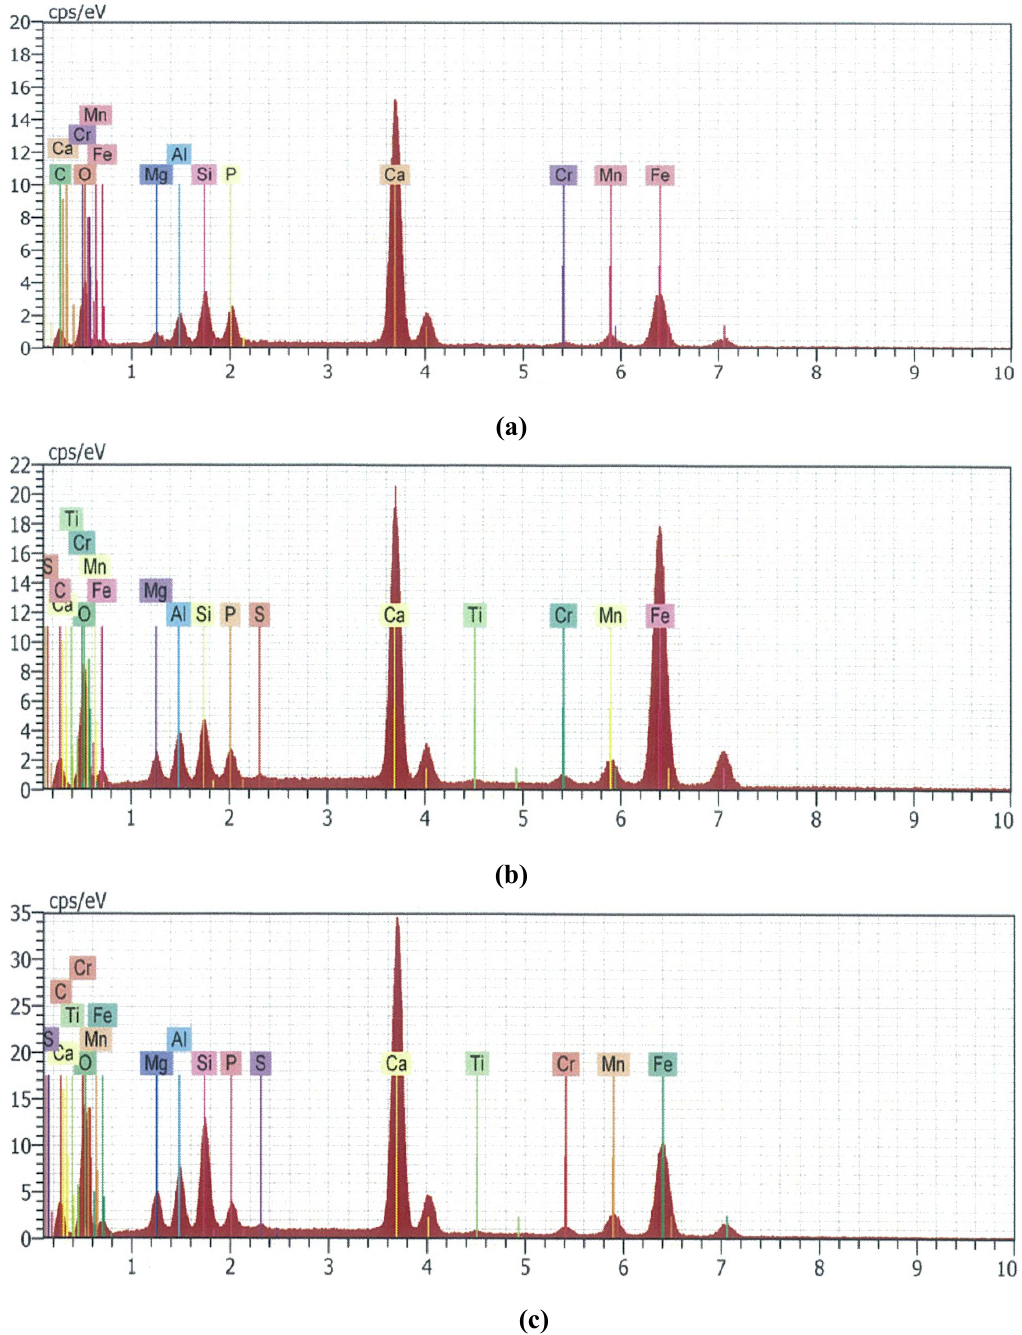
Figure 2. Semi-quantitative EDS results of spent slag from ( a ) P-only (P removal: 95%); ( b ) P + Cu (P removal: 68%); ( c ) P + Mix (P removal: